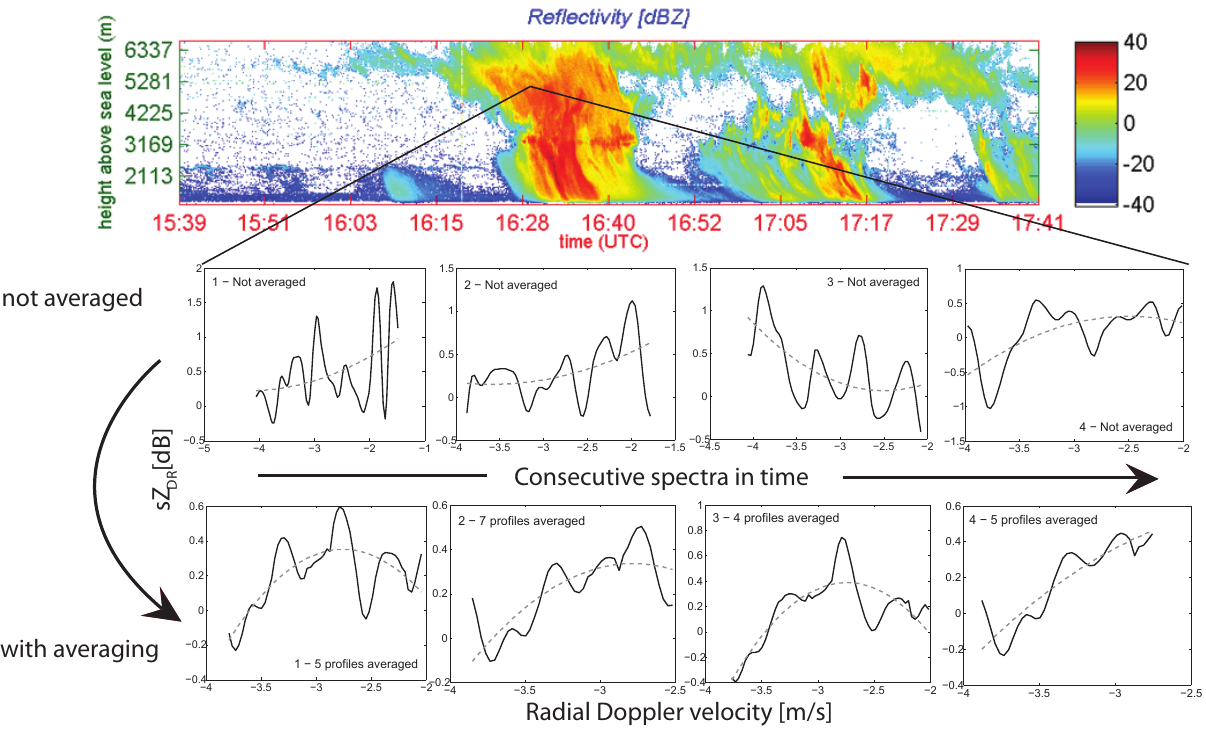
Fig. 7. Four consecutive sZ DR spectra extracted from an ice cloud region (see reflectivity profile). Each spectrum is measured at 1.5s interval and averaged (bottom row) over a different averaging time. The set of spectra are represented without (middle row) and with (bottom row) the additional averaging step. As displayed, the spectra become more coherent when the averaging is